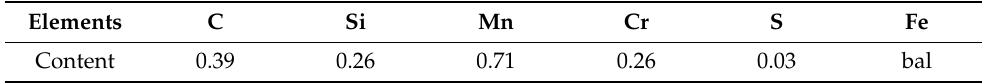
Table 1. The chemical composition of AISI 1045 steel (wt